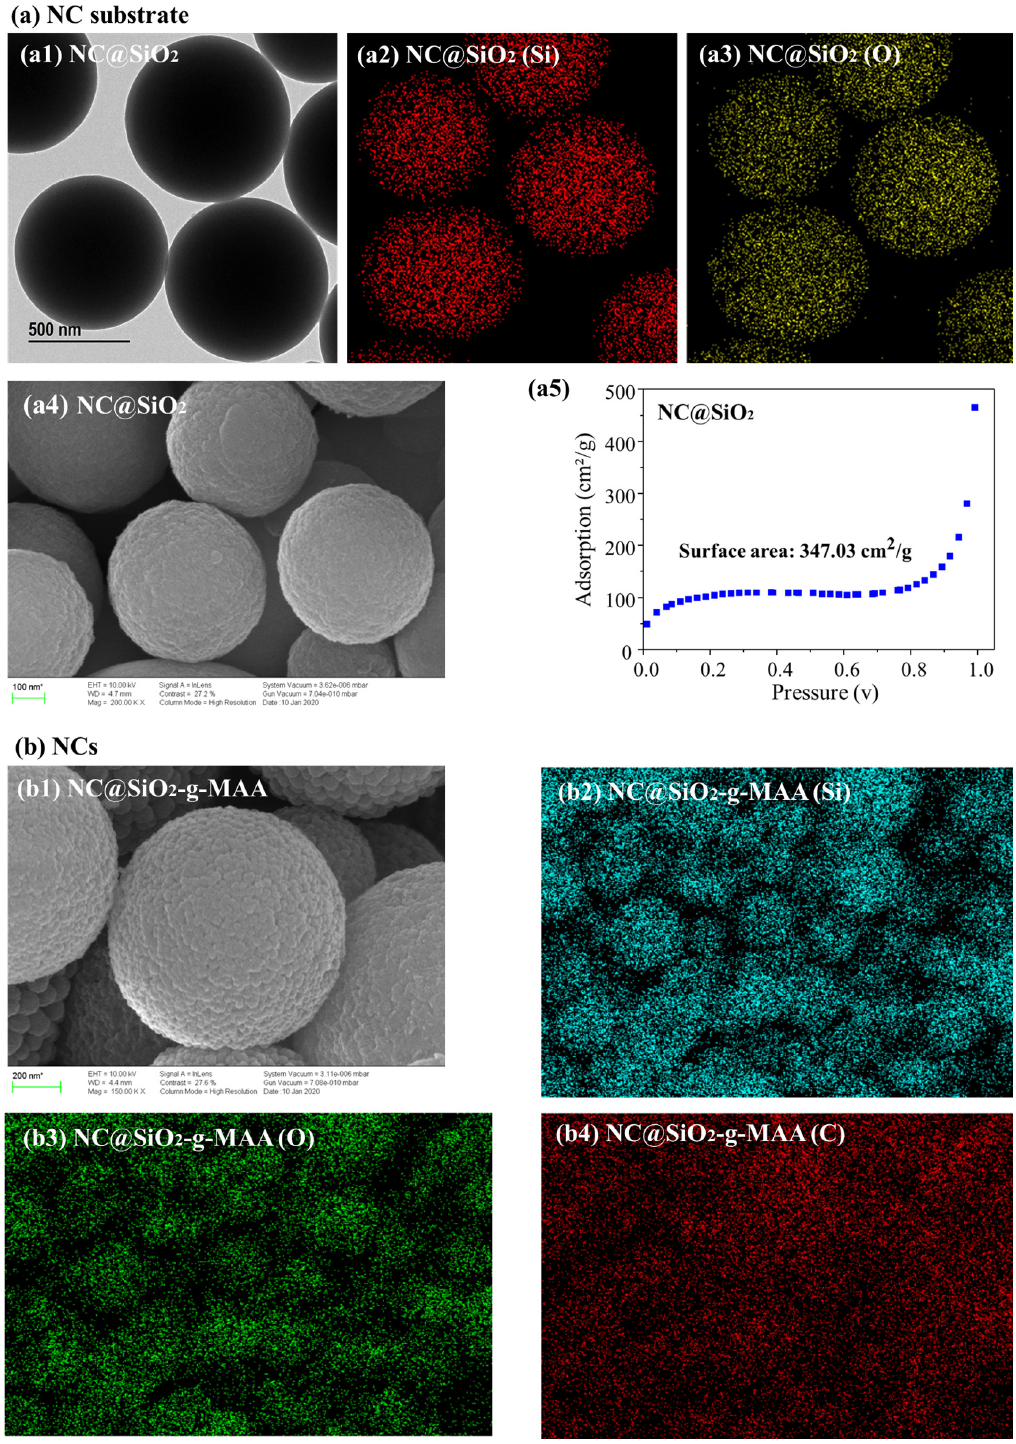
Figure 3. Analysis of morphology, surface shape, composition, and surface area of the ( a ) NC substrate and ( b ) self-antimicrobial NCs; ( a1 ) shape analysis of the NC substrate (NC@SiO 2 ) by TEM, ( a2 ) Si group determination, ( a3 ) O group determination, ( a4 ) surface morphology by SEM, ( a5 ) surface area by BET analysis, ( b1 ) surface morphology by SEM on the NCs, ( b2 ) Si group determination, ( b3 ) O group determination, and ( b4 ) C group